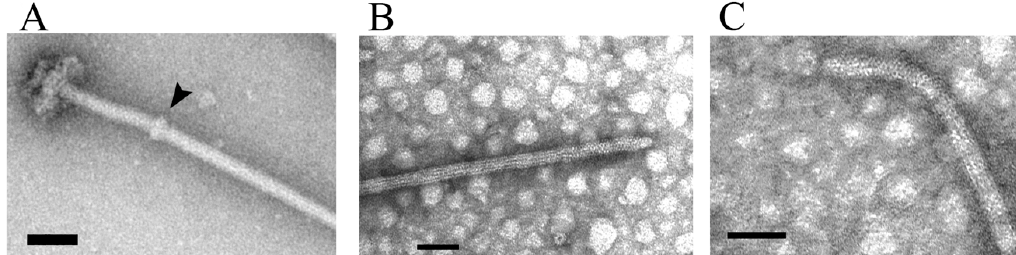
Figure 3. Electron micrographs showing ( A ) wild-type Fla1 filament-hook-basal body [62], arrow denotes the bulky HAP region; ( B ) sheared Fla1 wild-type filament-hook; ( C ) sheared Fla1 filament-hook from a mutant lacking residues 91–96 of FlgE [86]. Bar = 50 nm.